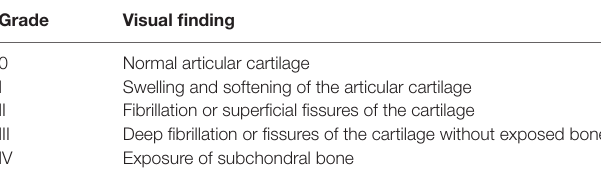
TaBle 1 | Outerbridge classification for grading the degeneration of